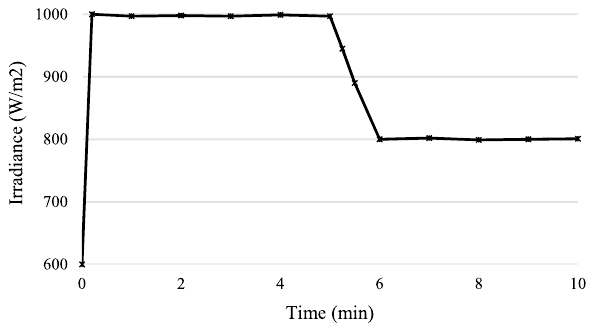
Figure 24. Measured solar irradiance profile under cloudy weather conditions.